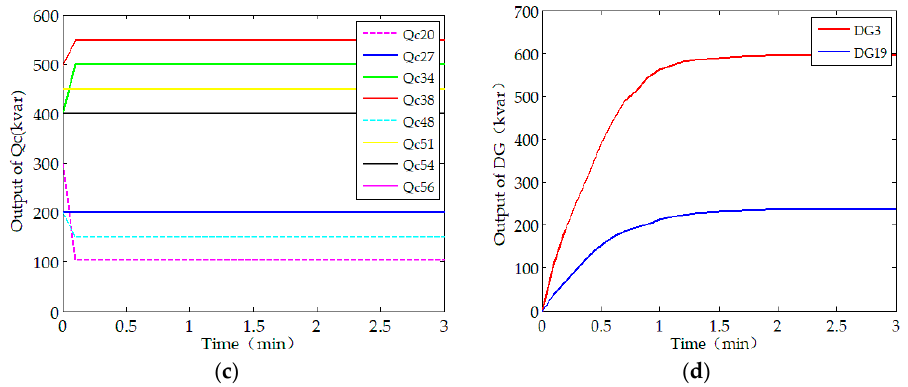
Figure 7. The optimal dispatch scheme under Scenario B: ( a ) Evolution of the objective function; ( b ) Voltage profiles with and without the distributed optimization solution; ( c ) Capacitor bank control sequences; and, ( d ) Output of DGs.